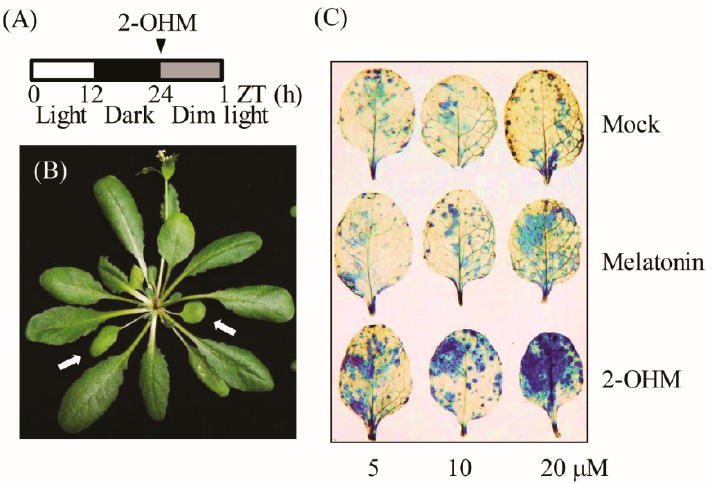
Figure 3. ( A ) Schematic of 2-OHM treatment in arabidopsis leaves under dim light conditions (7 μ mol m − 2 s − 1 ). ( B ) Arabidopsis leaves (arrows) grown for 6 weeks (first or second leaves) were